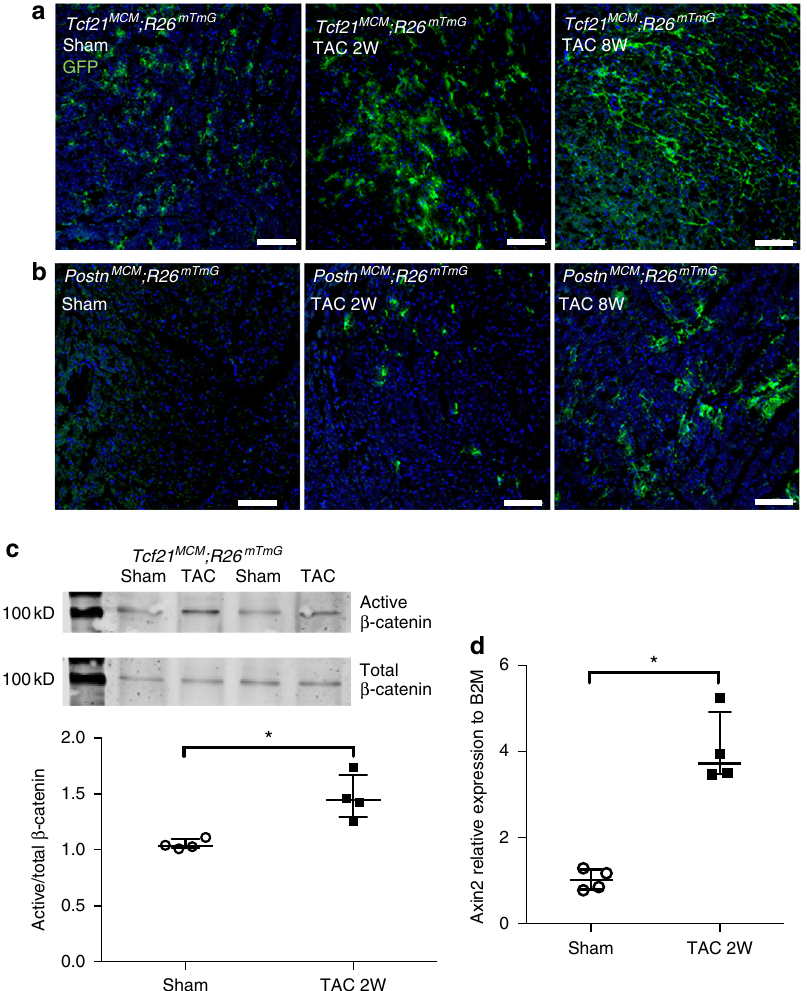
Fig. 1 Cardiac fi broblast (CF) lineages express Tcf21 and Postn tamoxifen-inducible Cre, and Wnt/ β -catenin is activated after TAC. Tcf21 MCM ;R26 mTmG and Postn MCM ;R26 mTmG mice were subjected to TAC and Cre-activity was induced by TAM food from day 0 after operation. a GFP-labeled CFs ( green ) were observed in Tcf21 MCM ;R26 mTmG sham-operated hearts 2 and 8 weeks after TAC with continuous TAM. b GFP-labeled CFs were only observed in Postn MCM ; R26 mTmG after TAC but not sham-operated hearts. Scale bar = 100 µ m. c Active and total β -catenin protein expression was determined by western blotting in GFP + CF extracts isolated from Tcf21 MCM ;R26 mTmG mice 2 weeks after TAC or sham operations. β -catenin signaling activation was determined by the ratio of activated to total β -catenin protein. d Expression levels of the Wnt pathway downstream gene Axin2 in GFP + CFs isolated from Tcf21 MCM ;R26 mTmG 2 weeks after TAC or sham operations were determined by quantitative PCR relative to B2M. Data points are shown with median and interquartile ranges indicated. Statistical signi fi cance was determined using unpaired Mann – Whitney U tests: * P < 0.05. N = 4 mice per